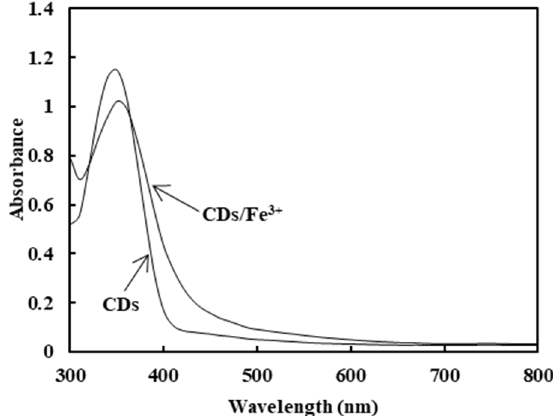
Figure 4. The UV absorption spectrogram of CDs and the CDs/Fe 3+ composite.